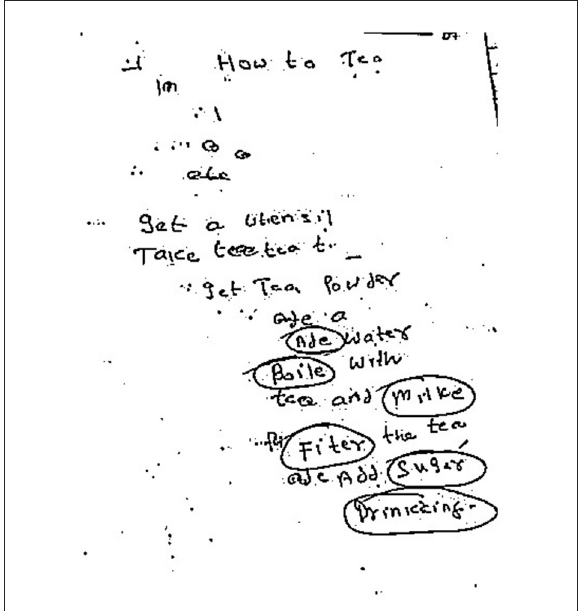
FIGURE1 Sample of written description task on a given